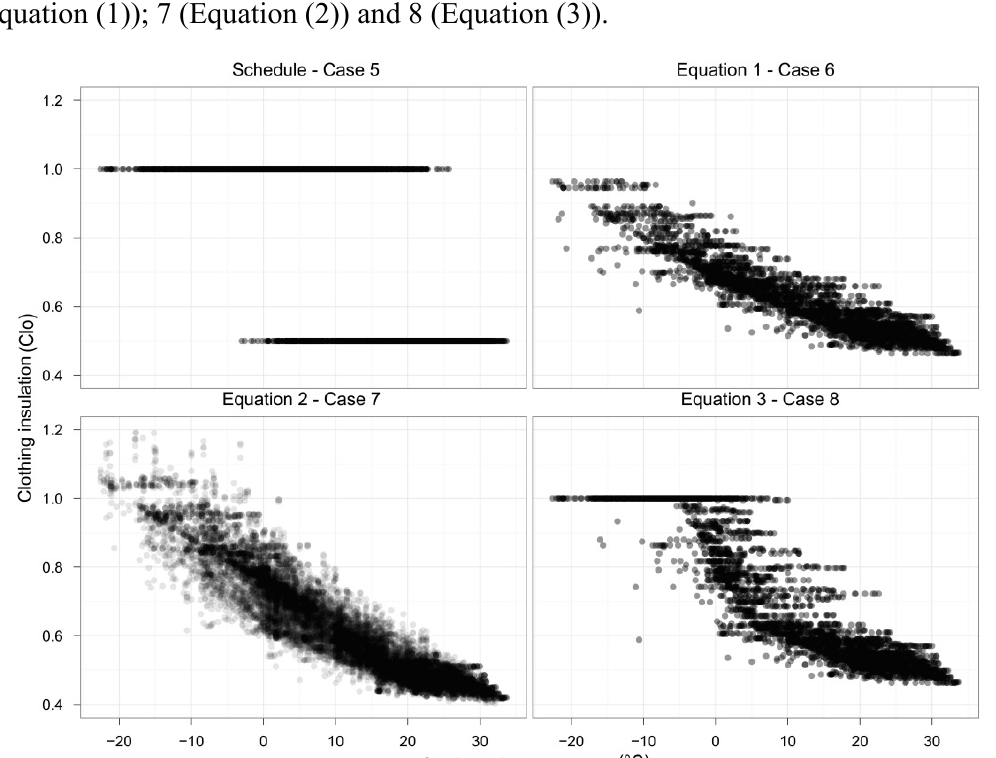
Figure 5. Outdoor air temperature vs. clothing insulation for Cases 5 (Schedule); 6 (Equation (1)); 7 (Equation (2)) and 8 (Equation